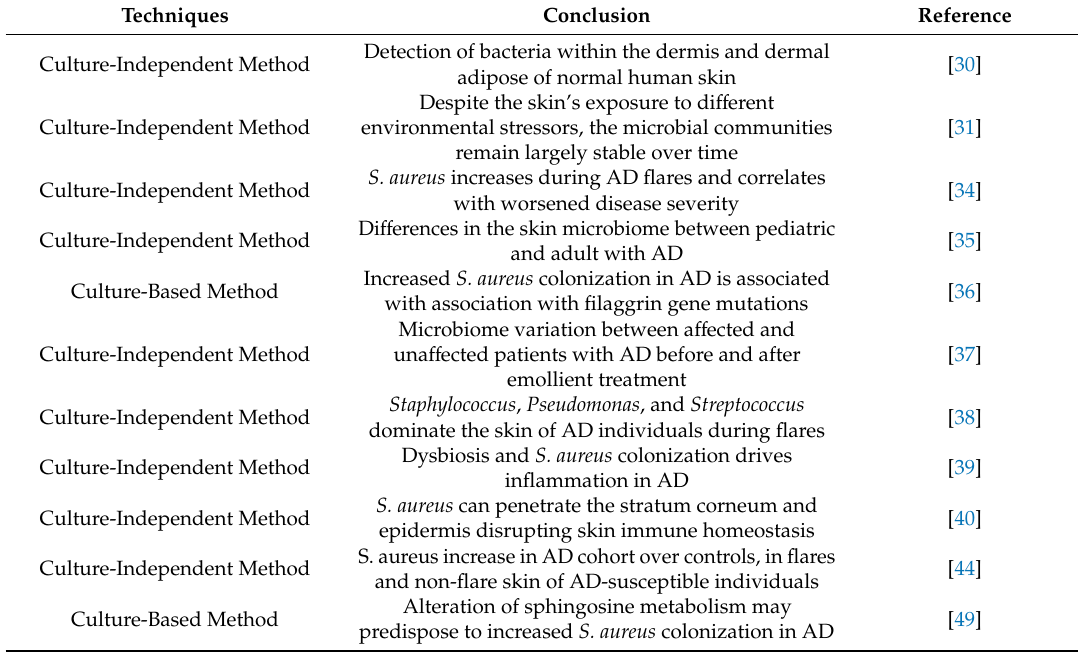
Table 1. Summary of the previous studies of the skin microbiota in health and atopic